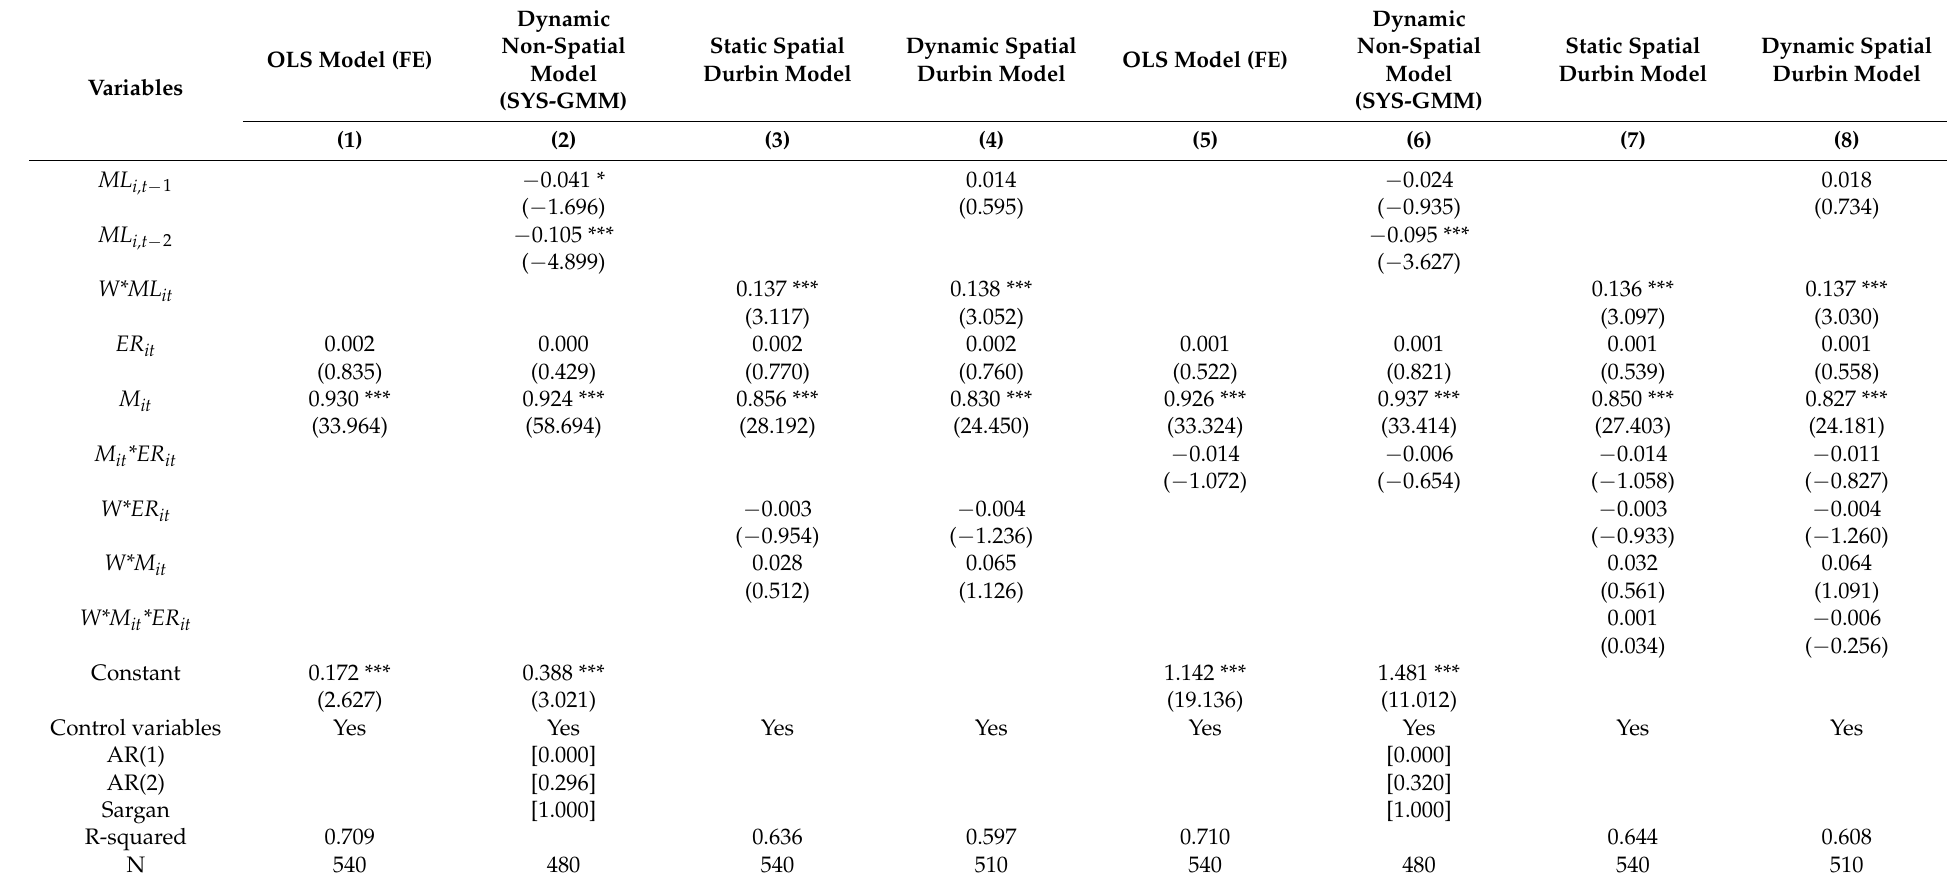
Table 2. The moderating results of technical change for the nexus between command–control environmental regulation and green